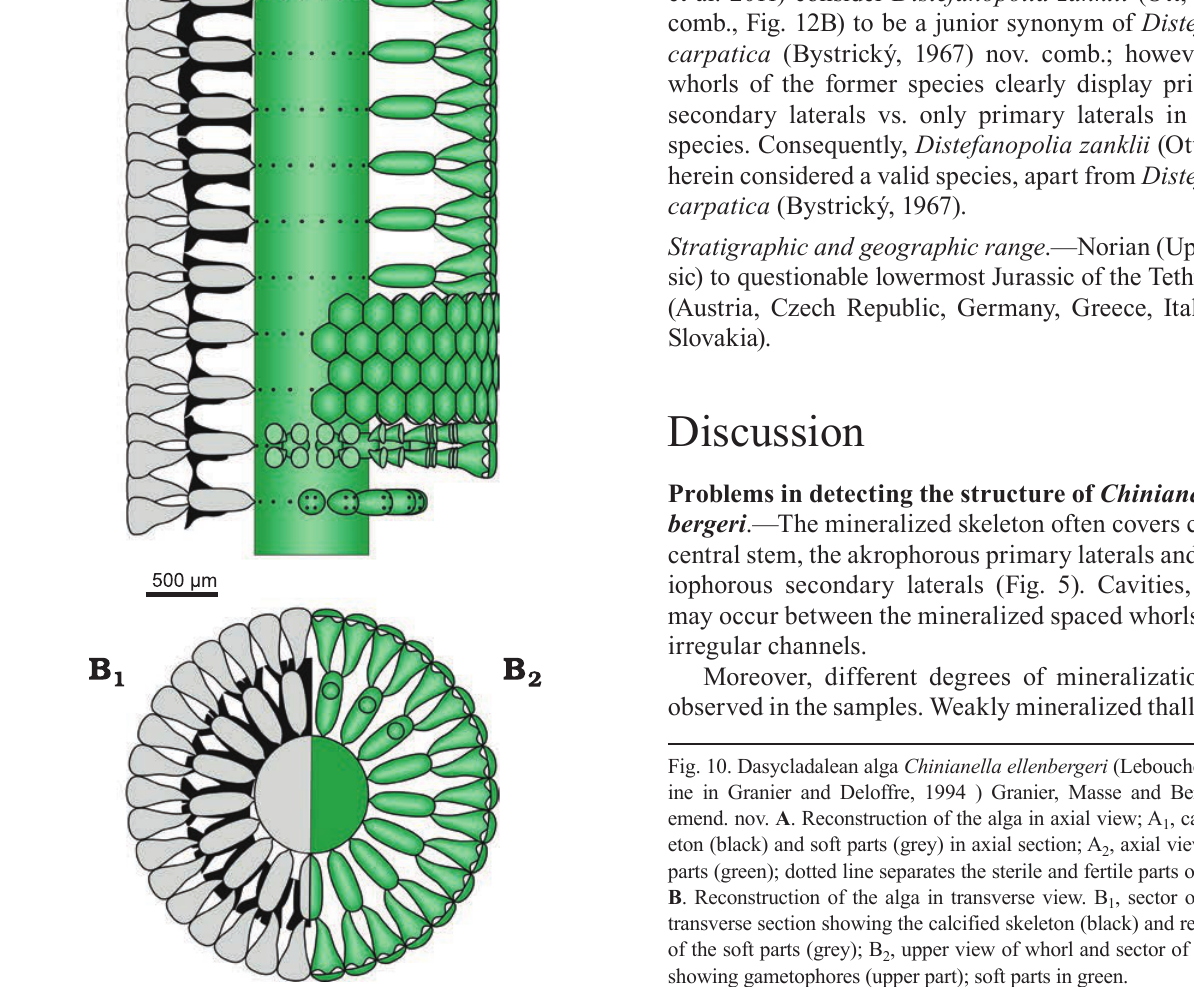
Fig. 10. Dasycladalean alga Chinianella ellenbergeri (Lebouché and Lemo- ine in Granier and Deloffre, 1994 ) Granier, Masse and Berthou, 1994, emend. nov. A . Reconstruction of the alga in axial view; A 1 , calcified skel- eton (black) and soft parts (grey) in axial section; A 2 , axial view of the soft parts (green); dotted line separates the sterile and fertile parts of the thallus. B . Reconstruction of the alga in transverse view. B 1 , sector of a whorl in transverse section showing the calcified skeleton (black) and reconstruction of the soft parts (grey); B 2 , upper view of whorl and sector of a whorl also showing gametophores (upper part); soft parts in → Fig. 9. Dasycladalean alga Chinianella ellenbergeri (Lebouché and Lemoine in Granier and Deloffre, 1994 ) Granier, Masse and Berthou, 1994, emend. nov., upper Sinemurian (Lotharingian), Canders, 2.4 km E of Fontcaude (S France). A . LM-DiSTAR/BA.577.1, n. 002, longitudinal section; note the regular interverticillar cavities, easily confused with fertile whorls. B . LM-DiSTAR/BA.577.12, n. 029, axial section; note false pores verging downwards (black arrow) and upwards (white arrow). C . LM-DiSTAR/BA.577.17, n. 075, slightly oblique section, with an annular channel (below) and vertical channels between laterals of a whorl (up). D . LM-DiSTAR/BA.577.39, n. 137, transverse-oblique section showing a crenate annular channel and vertical channels between the laterals of a whorl. E . LM-DiSTAR/BA.577.17, n. 070, tangential section; note the irregular spaces between mineralized tufts of secondary laterals, most tufts showing pores forming the corners of a parallelogram. F . LM-DiSTAR/BA.577.34, n. 133, tangential section showing tufts of three to four secondary laterals; adjacent triplets show opposite vergence. G . LM-DiSTAR/BA.577.6, n. 008, oblique section; note false pores, faking fertile whorls alternating with the calcified primaries. H . LM-DiSTAR/BA.577.11, n. 026, oblique section. I . LM-DiSTAR /BA.577.37, n. 135, tangential section; pores of adjacent mineralized whorls alternate in position; space between whorls is either unbroken or crossed by a thin irregular slit. J . LM-DiSTAR/BA.577.16, n. 060, oblique section; note interverticillar cavities sometimes verging downward (black arrow) or upward (white arrow). K . LM-DiSTAR/BA.577.8, n. 012, longitudinal-oblique section; a small false pore is present in calcareous sleeve close to the central cavity (upper part).